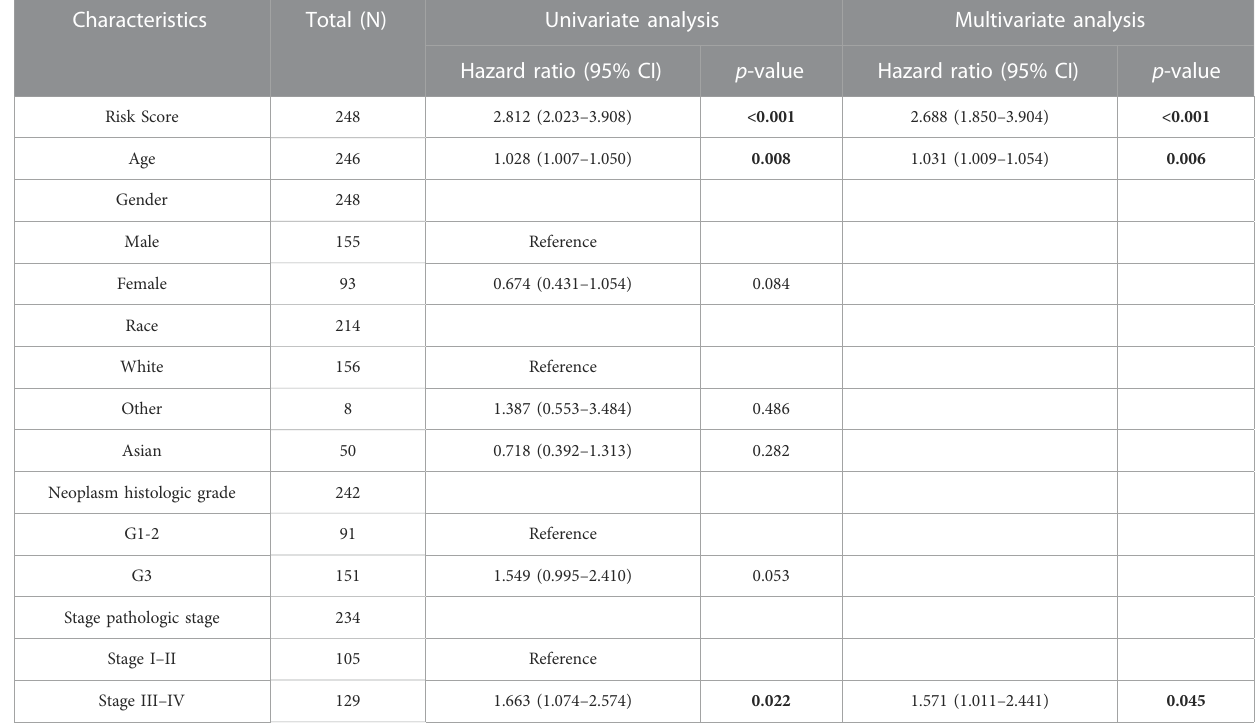
TABLE 2 Univariate and multivariate analyses of risk factors in the training cohort.